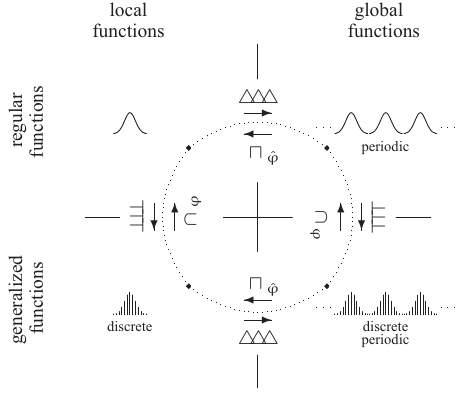
Figure 5. The same diagram as above, drawn in another fashion.